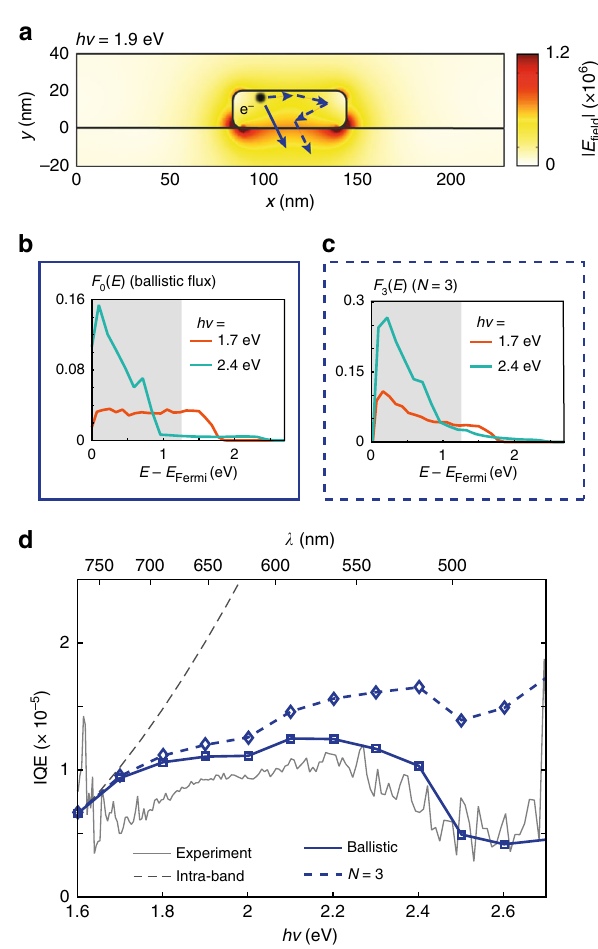
Fig. 4 Hot electron generation and transport in plasmonic nanoantennas. a Calculated spatial pro fi le of the electric fi eld norm | E fi eld | at resonance ( λ = 650 nm, h ν = 1.9 eV, E 0 = 2.56 × 10 5 V m − 1 ) for the experimental structure with W = 61 nm and P = 230 nm. | E fi eld | in the metal de fi nes the spatial generation pro fi le of the hot carriers. As schematically illustrated, hot electrons then propagate across the metal structure and reach the Au – GaN interface either ballistically (solid arrow) or after scattering (dashed arrows); b energy-resolved fl ux of hot electrons reaching the Au – GaN interface ballistically for photon energy of 1.7 eV (orange curves, weak interband contribution) and 2.4 eV (turquoise curves, strong interband contribution). The shaded area shows the position of the Schottky barrier; c same as b but including the fl ux of carriers that have undergone up to N = 3 scattering events; d IQE spectra calculated based on the computed energy-resolved fl uxes, both for the ballistic case (blue solid curve) and for N = 3 (blue dashed curve), under the assumption of tangential momentum conservation for the injection probability 21 . The gray dashed curve represents the IQE estimated based on the fi t of Fowler yield, solid curve is the experimentally determined IQE (Fig. 2g, blue curve)